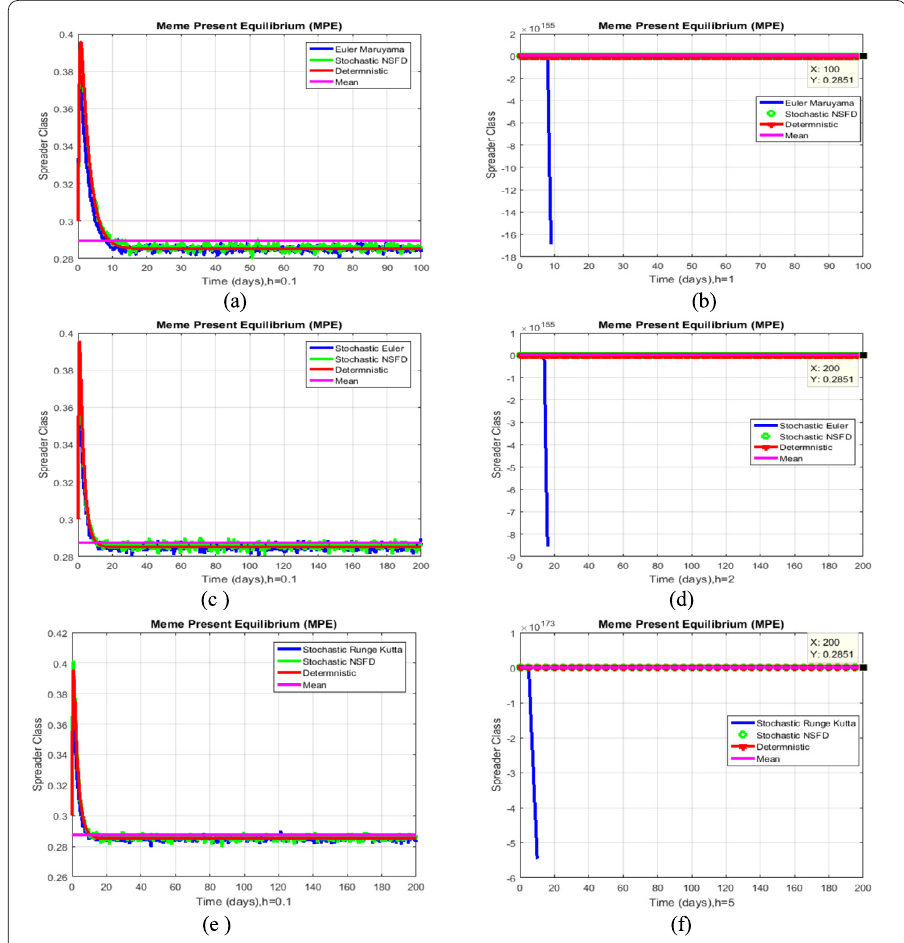
Figure 6 ( a ) Spreader class at h = 0.1 with Euler–Maruyama. ( b ) Spreader class at h = 1 with Euler–Maruyama. ( c ) Spreader class at h = 0.1 with stochastic Euler. ( d ) Spreader class at h = 2 with stochastic Euler. ( e ) Spreader class at h = 0.1 with stochastic Runge–Kutta. ( f ) Spreader class at h = 5 with stochastic